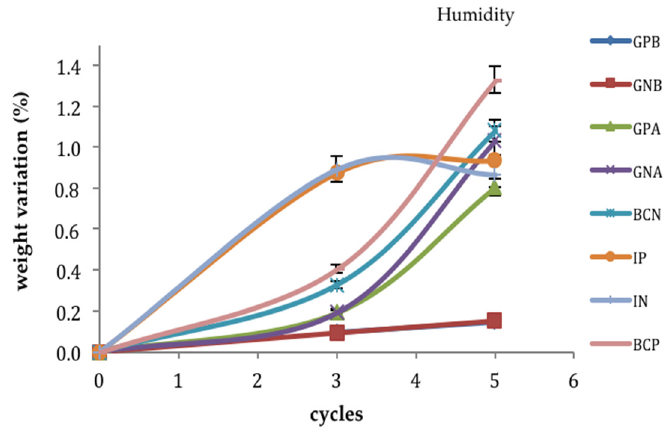
Figure 3. Variation in the weight of the specimens in humidity ageing tests. The sample codes are shown in Table 1.